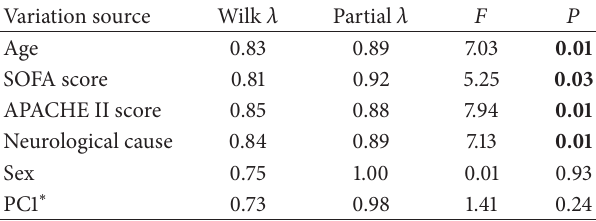
Table 3: Results of multivariated analysis using canonical discrim- inant analysis (CDA) for the occurrence of delirium . The variables maintained in the model ( 𝑃 < 0.05 ) and used to generate the canonical root are shown in